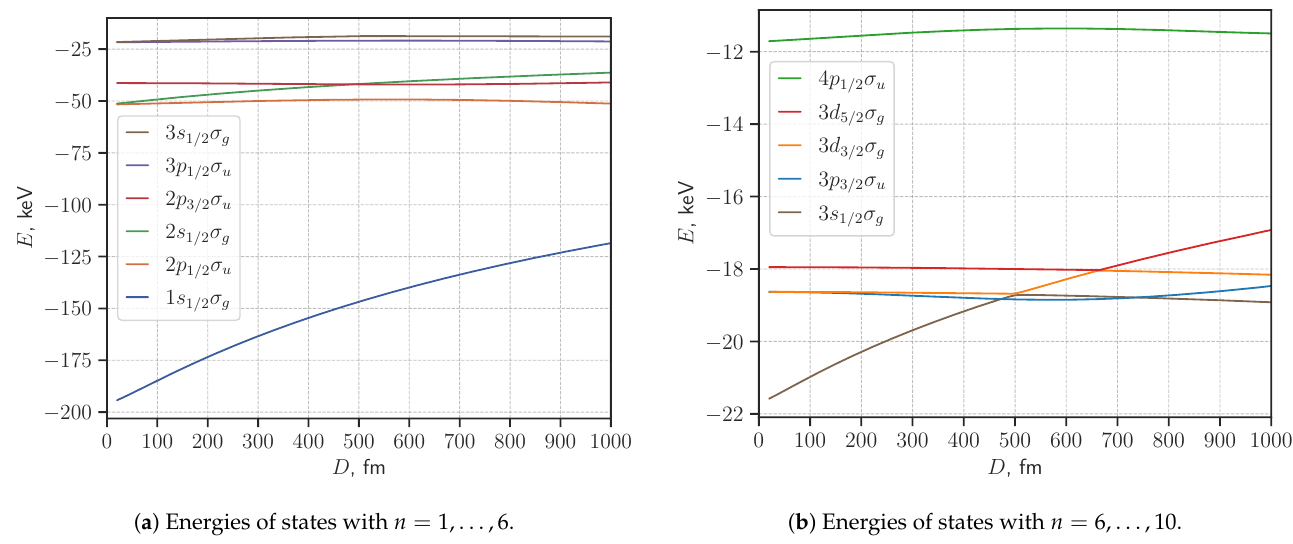
Figure 3. Electronic terms of the one-electron Xe 54 + –Xe 54 + quasimolecule. Table 2. Ground-state binding energy E 1 σ (in eV) of the Pb 82 + –Pb 82 + –e − quasimolecule for the two-center potential (TC) g and for the monopole-approximation potential (MA), with the coordinate system origin at the center of mass of the nuclei ( 1 ) and at the one of the nuclear centers ( 2 ) .